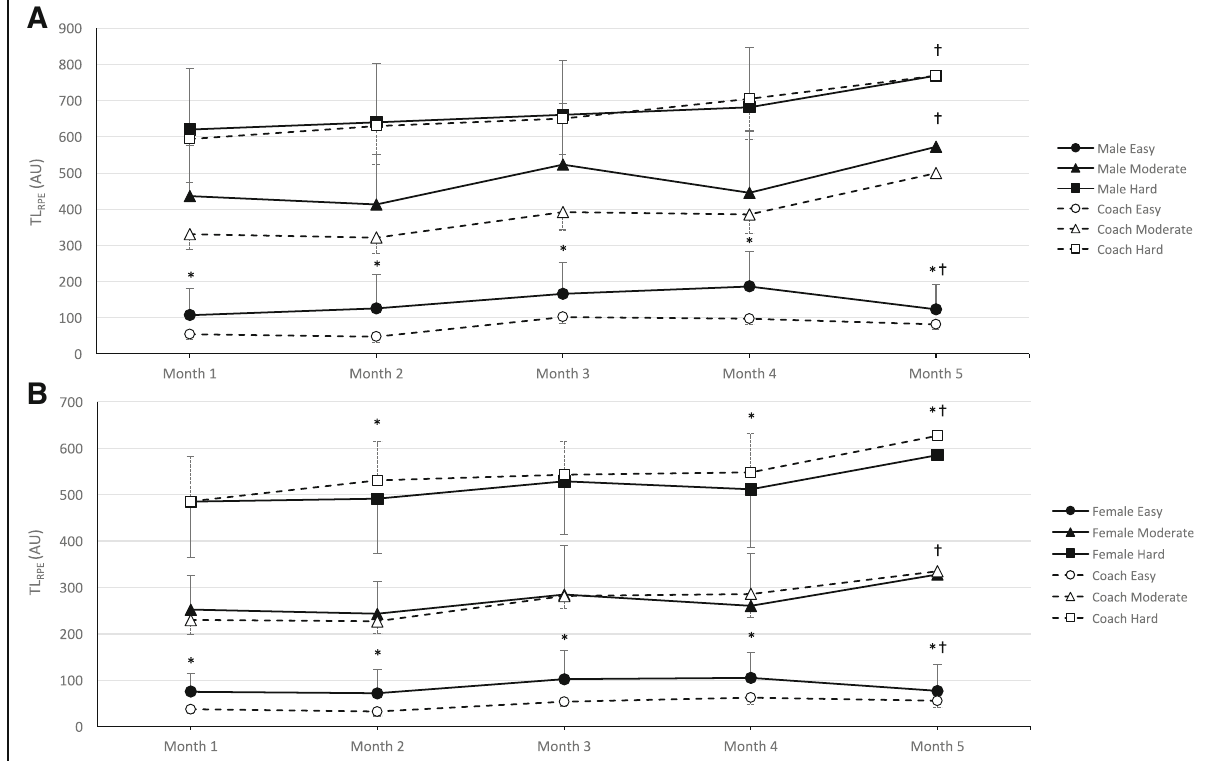
Fig. 2 Comparison of training load (TL RPE ) between coaches and male runners ( a ) and between coaches and female runners ( b ) for easy, moderate, and hard sessions during each month of the cross-country season (1 – 5). Month 5 only included one moderate session and one hard session. AU arbitrary units; asterisk indicates significantly different between athlete and coach within respective month, p < 0.01; dagger indicates significantly different than month 4, p <